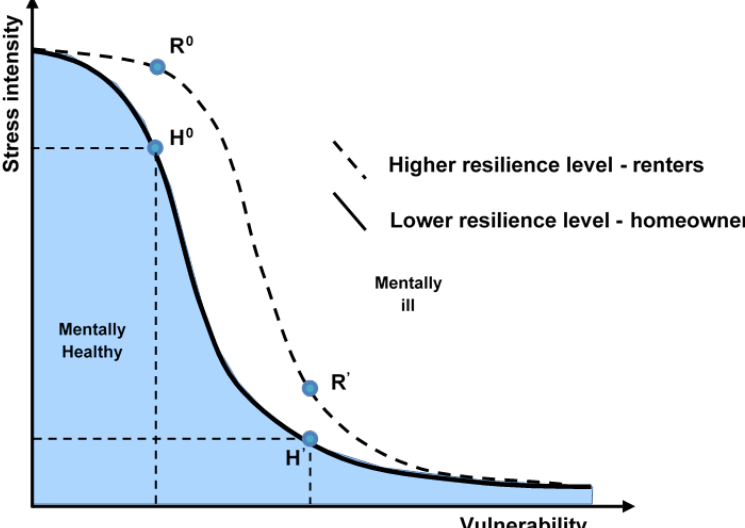
Figure 1. Adpated from Zubin and Spring [32]’s vulnerability–stress model in moving home. People less vulnerable to stress need to experience a great deal of stress before be- coming distressed and mentally ill. In contrast, people who are highly vulnerable to stress require only a small amount of stress to “tip them over the edge” into mental illness. Stress leads first to anxiety, which can tip the person into full-blown psychosis. As the model states, a person with low vulnerability becomes mentally ill only at a very high-stress intensity (i.e., more resilient at point R 0 ). A vulnerable person would easily become ill despite a very low-stress level (i.e., at point H’). With the same vulnerability level, a person at a higher resilience level can tolerate more stress than a person at a lower resilience level without becoming ill (R 0 > H 0 and R’ > H’ with the same vulnerability